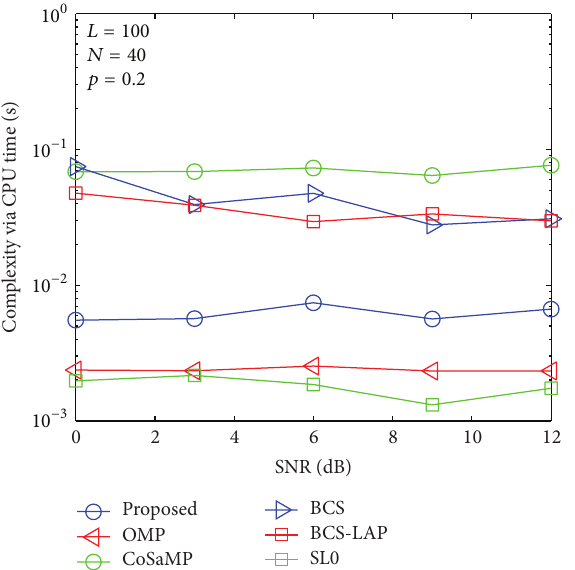
Figure 16: Computational complexity comparison via CPU time when 𝑝 1 = 0.2 and 𝑁 = 40